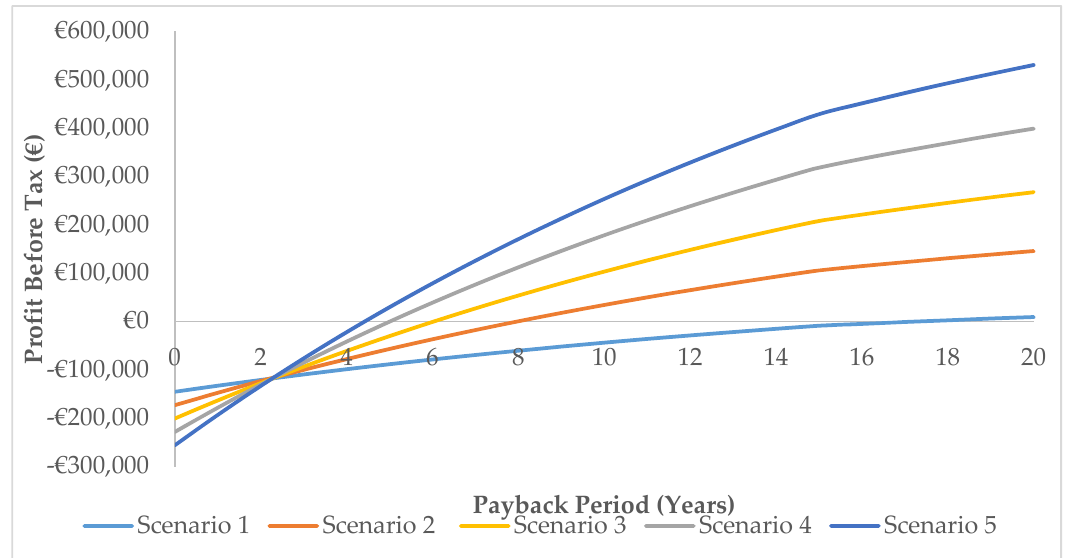
Figure 5. Comparison of discounted payback periods of scenarios.